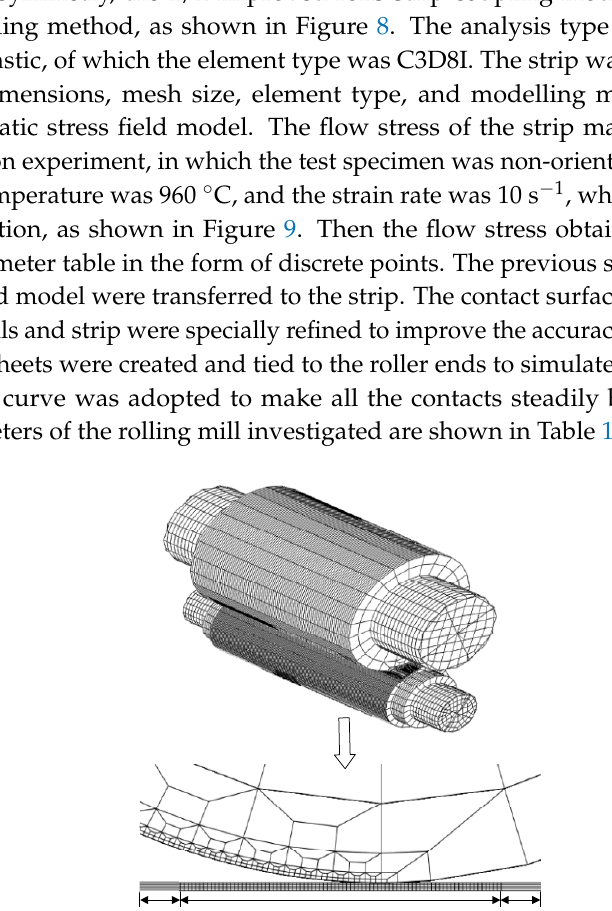
Figure 7. Strip model based on FE-IE coupling method.